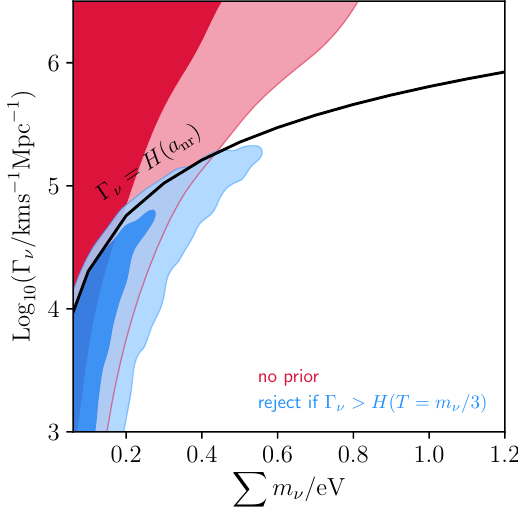
(Γ [km / s / Mpc]) when confronted to Planck ν / 10 (see ν